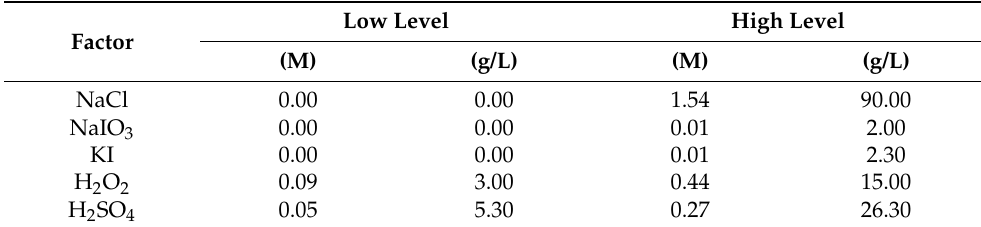
Table 3. Factors included in the experimental design and their levels.